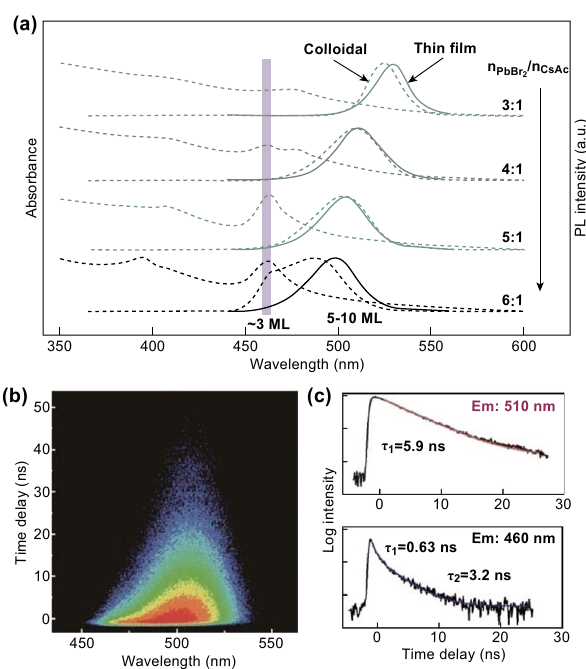
Fig. 4 a Absorption and photoluminescence spectra of CsPbBr 3 NCs, showing the PL fine-tuning ability of our synthesis. The purple stripe highlights the excitonic peak of the 3-monolayer nanosheets. b 2D pseudo-color transient emission map from CsPbBr 3 nanosheets colloid (Pb/Cs = 5/1). Streak camera measurement was taken under excitation at 410 nm, flux at 1 pJ cm −2 . c PL decay traces extracted at 460-nm and 510-nm window (± 5